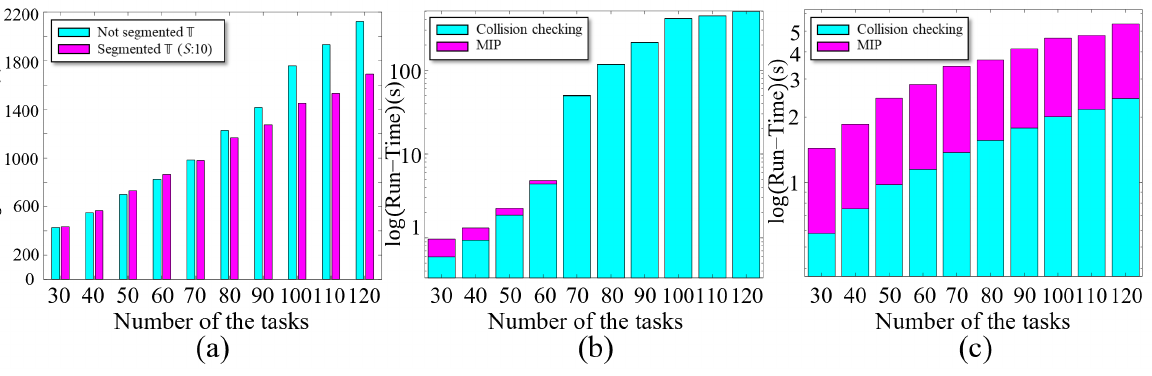
Figure 4. The comparison result of the full-sized T and segmented T . Each T contains 2 dishes and 30 to 120 tasks. ( a ) The result of the total elapsed time (makespan + run-time). ( b ) The run-time result of the experiment using full-sized T . ( c ) The run-time result of the experiment using segmented T